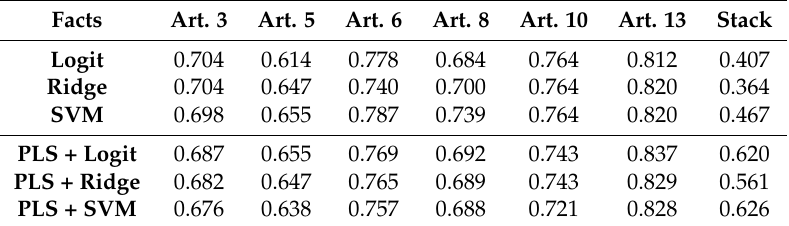
Table 4. Accuracy with binary input on